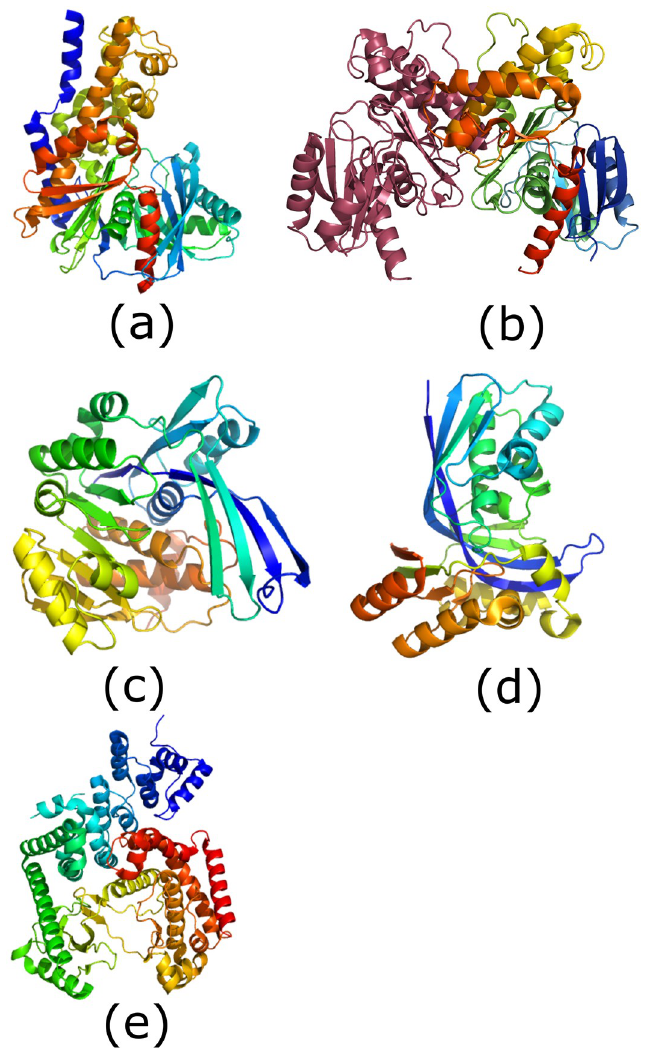
Figure 1. Structures of the five carbohydrate kinase classes. All images are shown in rainbow format (blue: N -terminus, red: C -terminus). ( a ) Structure of human glucokinase (hexokinase class; PDB (protein data bank) ID: 4IWV). ( b ) Structure of Bacillus subtilis fructokinase dimer: second molecule shown in raspberry (ROK kinase class; PDB ID: 1XC3 [17]). ( c ) Structure of Escherichia coli ribokinase (ribokinase class; PDB ID: 1RKD; [18]). ( d ) Structure of Aquifex aeolicus IspE (GHMP kinase class; PDB ID: 2V2Z; [19]). ( e ) Structure of human PIK3C3 (phosphatidylinositol phosphate kinase class; PDB ID: 3IHY). Images generated using PyMOL (version 1.8, Schrodinger, New York, NY, USA).